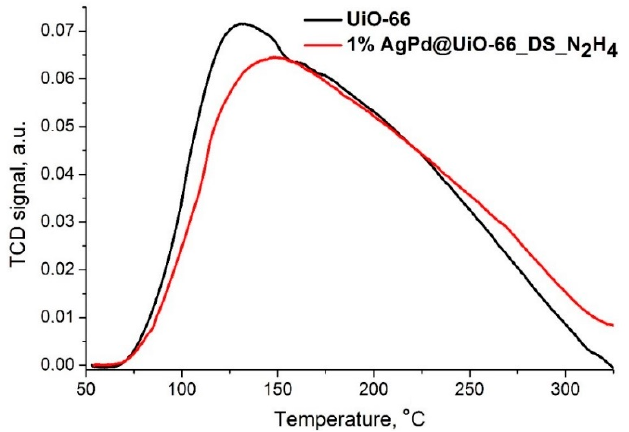
Figure 5. NH 3 -TPD profile of UiO-66 (black) and 1% AgPd@UiO-66 prepared by using DS_N 2 H 4 (red).